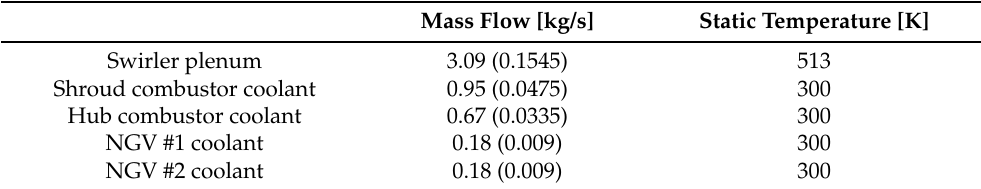
Figure 1. Fully integrated FACTOR configuration. Film holes are highlighted on the lower and upper walls of the chamber and on the blade surfaces. Table 1. Mass flows and temperatures of the different inlets for the 360 ◦ configuration. Values for the 18 ◦ sector are in